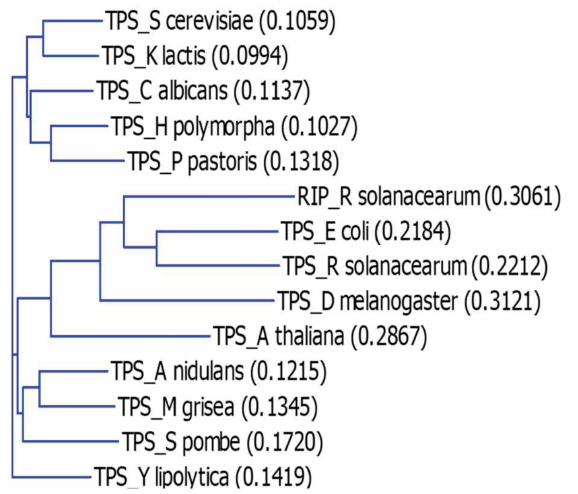
FIGURE 1 : Phylogenetic tree of TPS protein homologues. Phylo- genetic tree calculation is based on a sequence distance method and utilizes the Neighbour Joining algorithm of Saitou and Nei [31].